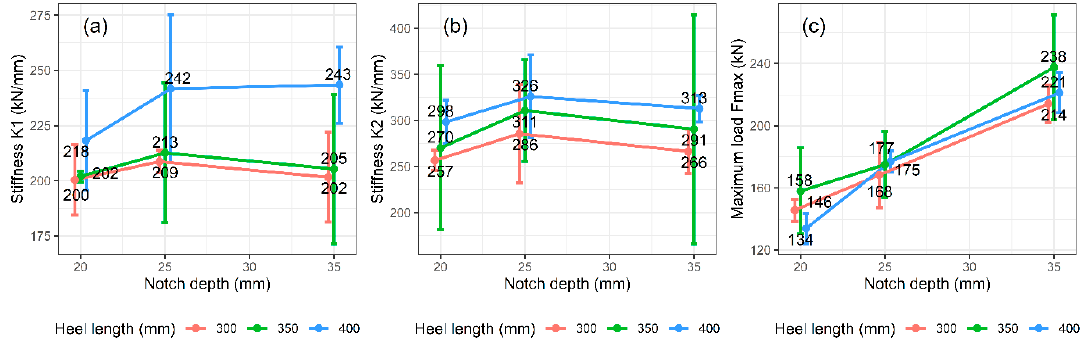
ff ness K1 ( a ), K2 ( b ), and maximum load Fmax ( c ) of di ff erent heel Figure 7. Stiffness K1 ( a ), K2 ( b ), and maximum load Fmax ( c ) of different heel lengths. Figure 7. Sti